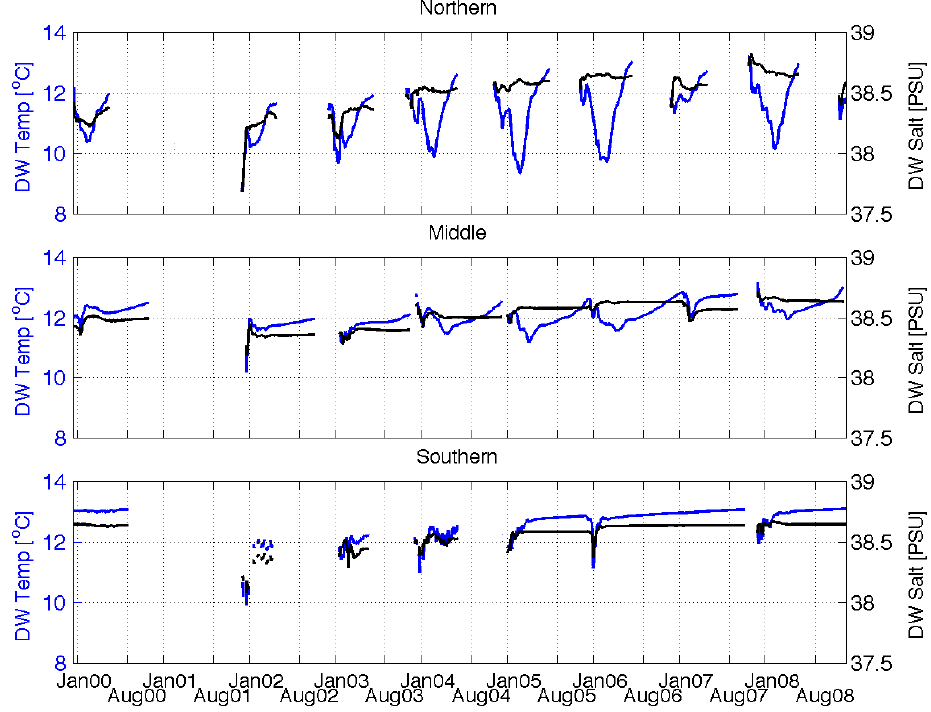
Fig. 12 Daily time-series of mean Temperature (blue lines, left Y axis) and Salinity (black lines, right Y axis) of waters masses having sigma_t > 29.2 in the Northern, Middle and Southern sub- Fig. 12. Daily time-series of mean Temperature (blue lines, left Y-axis) and Salinity (black lines, right Y-axis) of waters masses having basins. sigma- t > 29.2 in the Northern, Middle and Southern